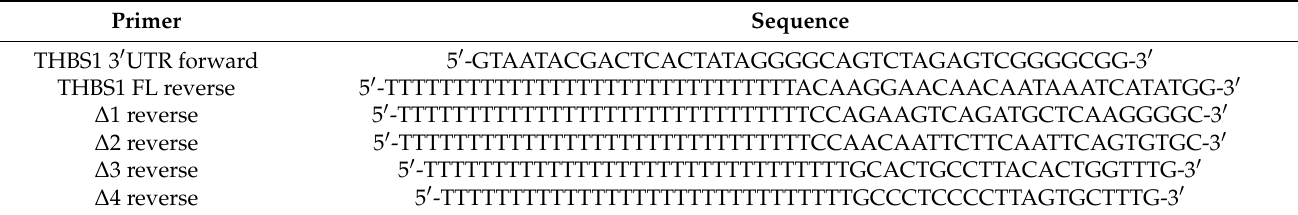
Table 1. HBS1 3 (cid:48) UTR deletions.